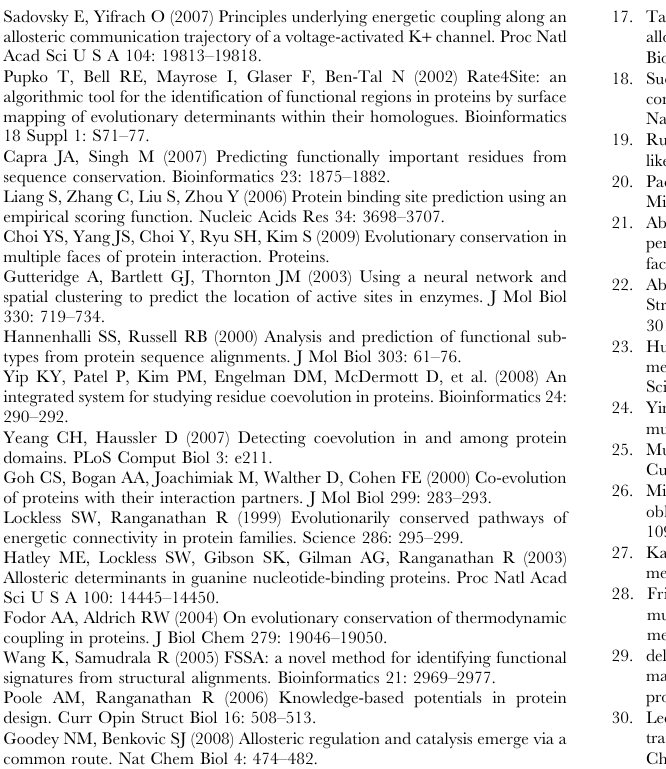
Table S4 List of central cavity residues in glycerol-3-phosphate transporter (GlpT). Table S5 Interaction network of detected residues in GlpT. Table S6 Functional implications and experimental evidence of the detected GlpT residues. Table S7 List of central cavity residues in multidrug transporter EmrD. Table S8 Interaction network of detected residues in EmrD. Table S9 Functional implications and experimental evidence of the detected EmrD residues. Table S10 Identified functional residues of membrane protein